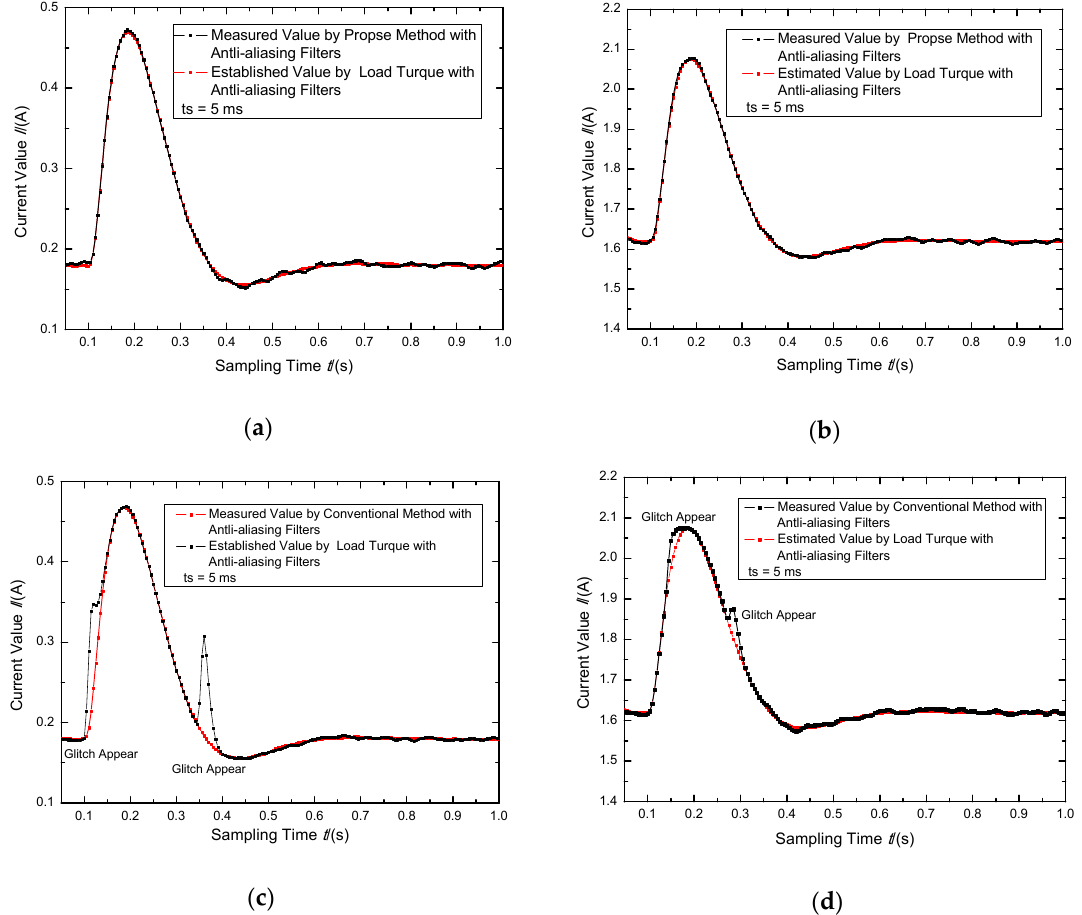
Figure 10. Measurement result obtained by performing ( a ) the proposed method on small continuous working current of the steering motor, ( b ) the proposed method on large continuous working current of the steering motor; and measurement result obtained by performing ( c ) conventional method on small continuous working current of the steering motor, ( d ) conventional method on large continuous working current of the steering motor.